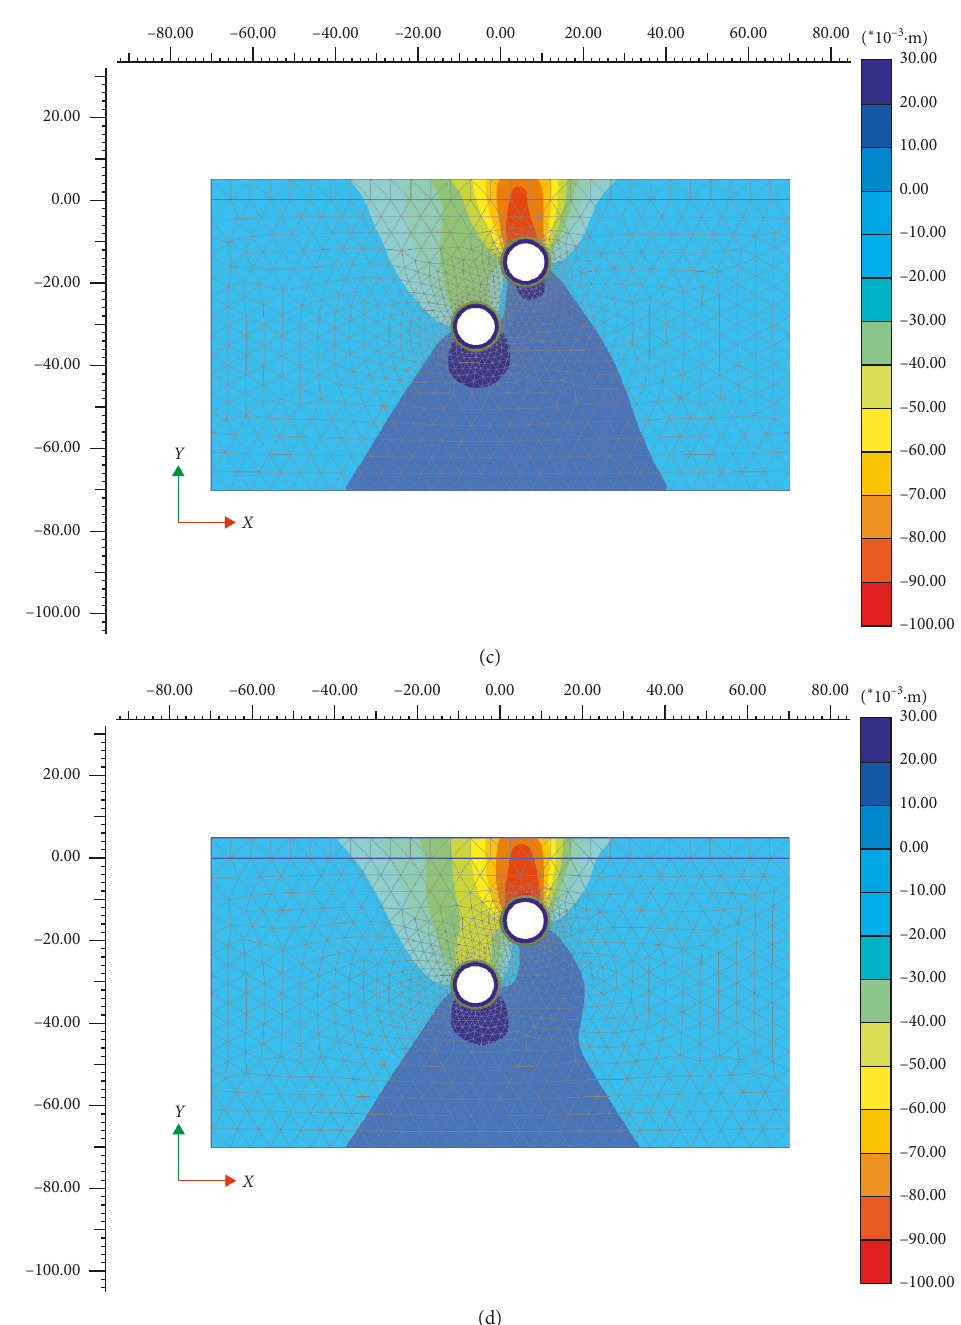
Figure 7: (a) Twin tunnels ( u 0.55 D ) in skewed configuration (dimensions in cm). (b) Settlement trough of skewed twin tunnels (cid:31) ( u 0.55 D ). (c) Displacement contours of skewed twin tunnels (top constructed first). (d) Displacement contours of skewed twin tunnels (cid:31) (bottom constructed